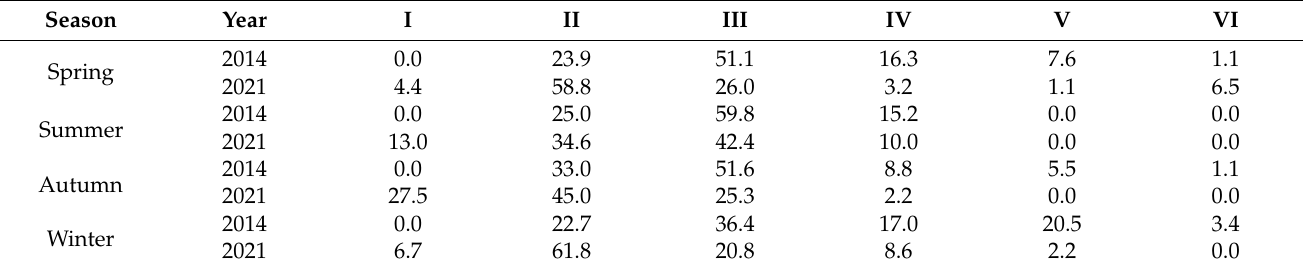
Table 4. The ratios of AQI rank from 2014 to 2021 in Jinan City (%).